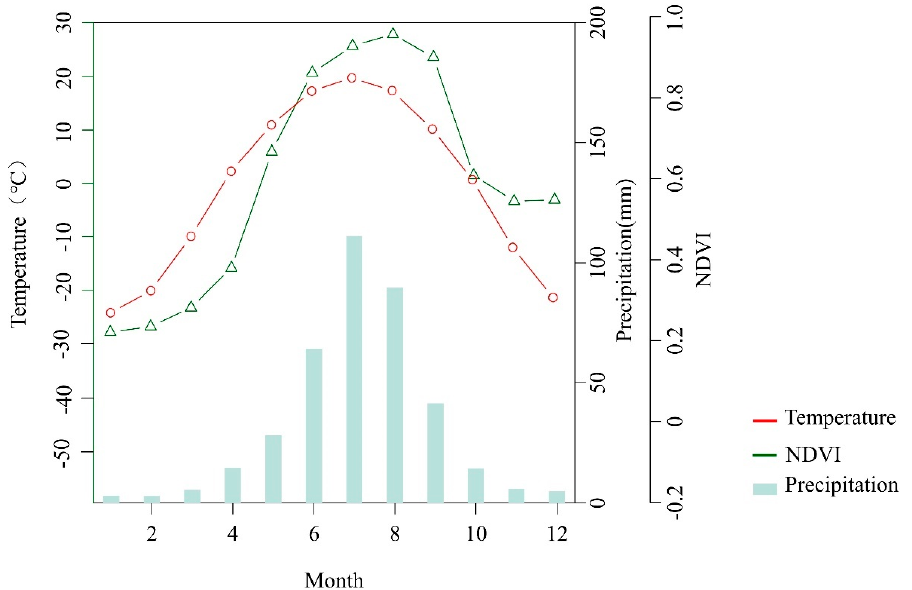
Figure 2. The monthly mean temperature (circle curve), monthly mean NDVI (triangle curve), and monthly total precipitation (bar graph) for the study area were obtained from the available records of nine meteorological stations; time span: 1951 − 2019.